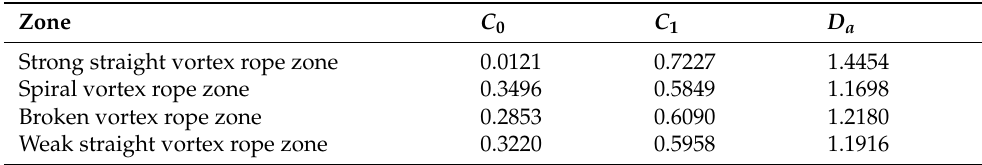
Figure 12. Fractal dimension relation of all vortices’ circumferences and areas on the sections of the draft tube. Table 4. Dimensions of peripherals of vortices in different